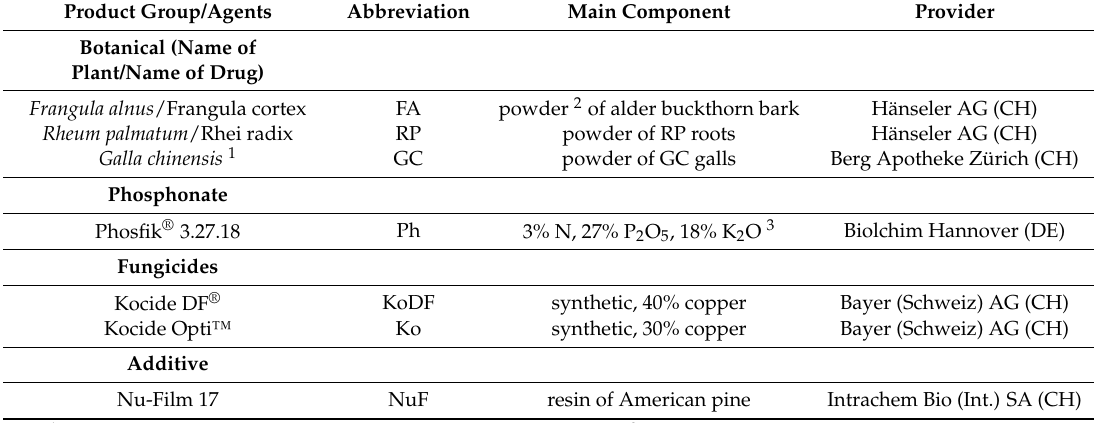
Table 1. Antifungal agents and additive evaluated for their effect against Phytophthora infestans in laboratory and field